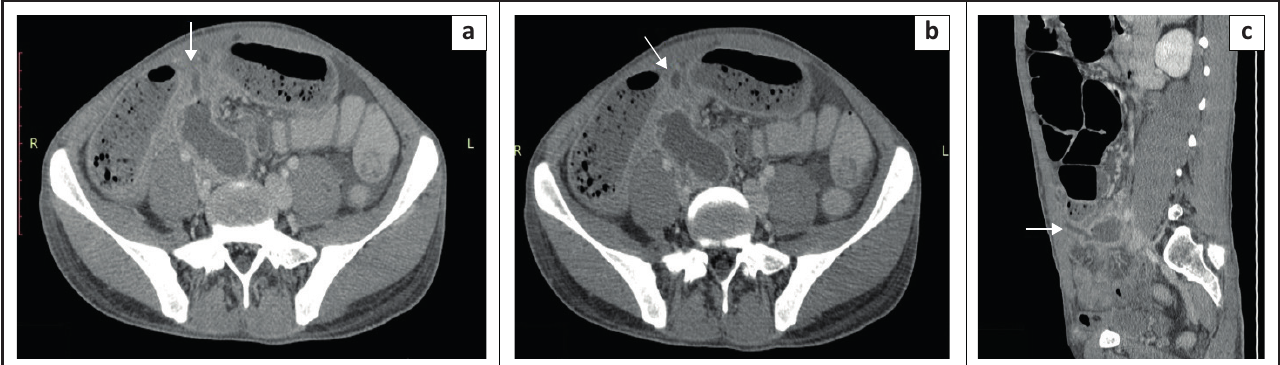
FIGURE 4: Contrast enhanced computed tomography in the axial (a, b) and sagittal (c) planes revealed a Meckel’s diverticulum (white arrows) with wall thickening and enhancement, surrounded by fat inflammation suggestive of Meckel’s